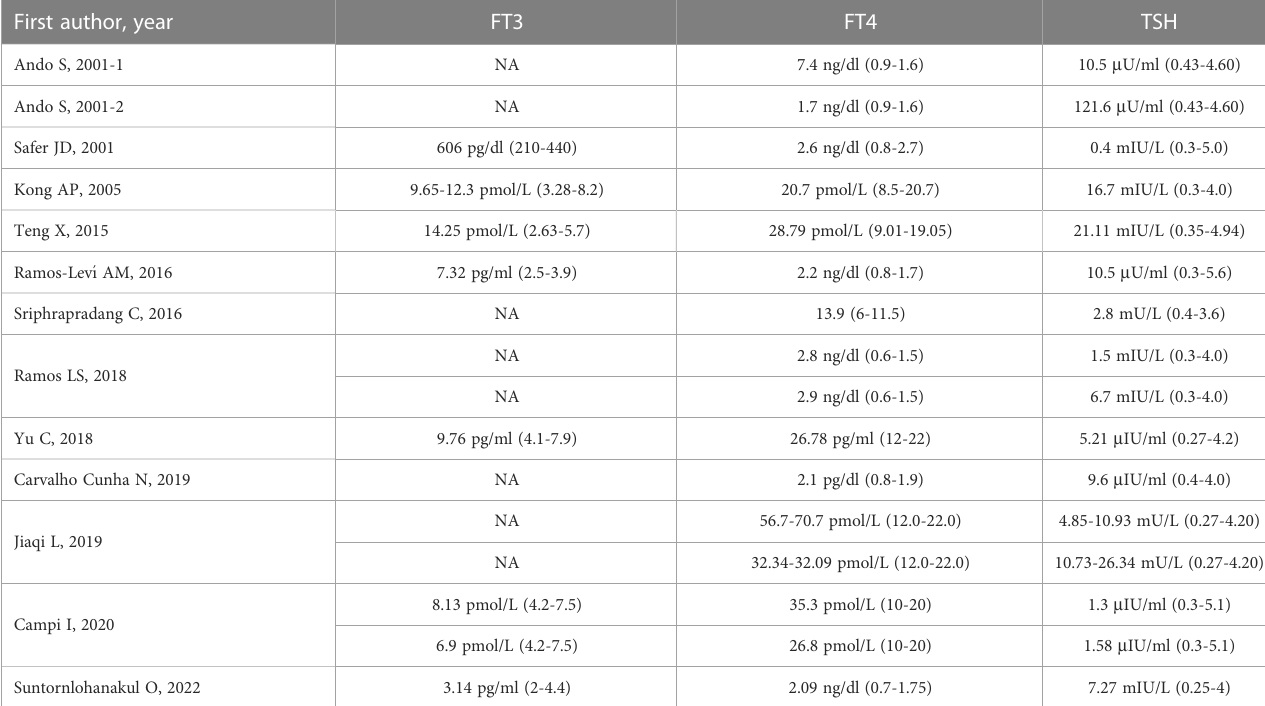
TABLE 1 Summary of thyroid